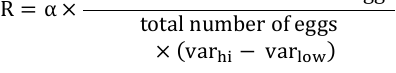
Figure 5. Random egg-laying in ELR. Central red star is the initial habitat of cuckoo with 5 eggs; pink stars are eggs’ new